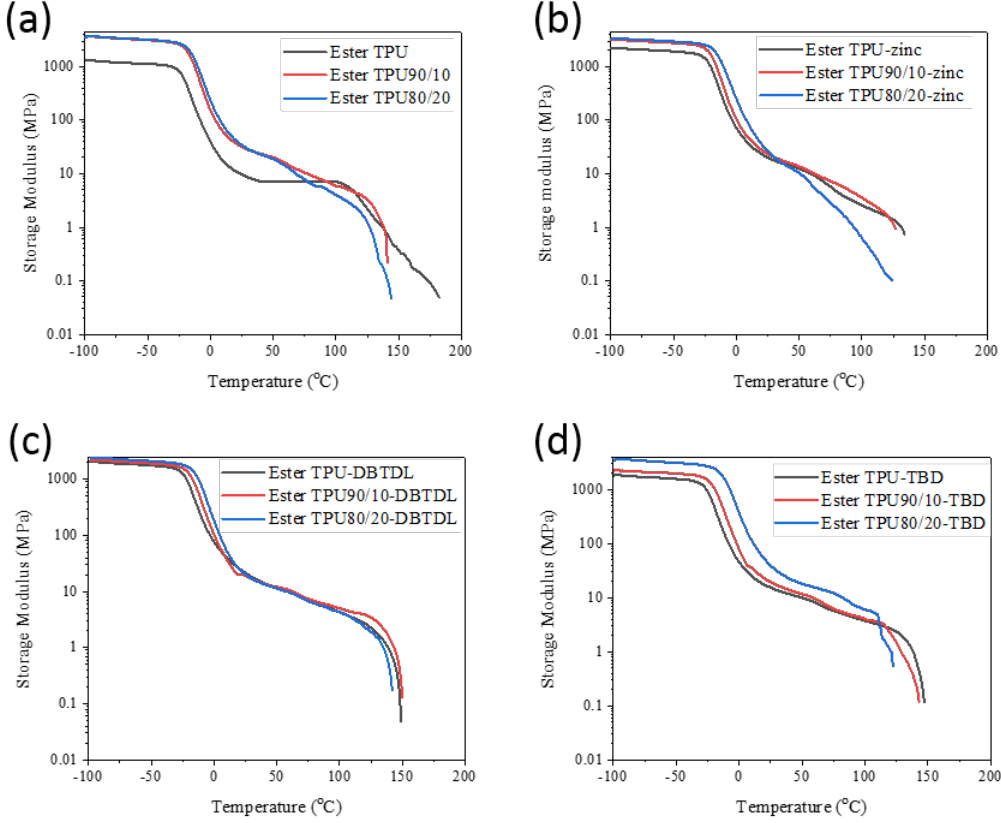
Figure 8. Dynamic mechanical analysis (DMA) curves of ester TPU / phenoxy blends: ( a ) Storage modulus for the ester TPU blends without the catalyst; ( b ) storage modulus for the ester TPU blends with zinc acetate as the catalyst; ( c ) storage modulus for the ester TPU blends with DBTDL as the catalyst; ( d ) storage modulus for the ester TPU blends with TBD as the catalyst.